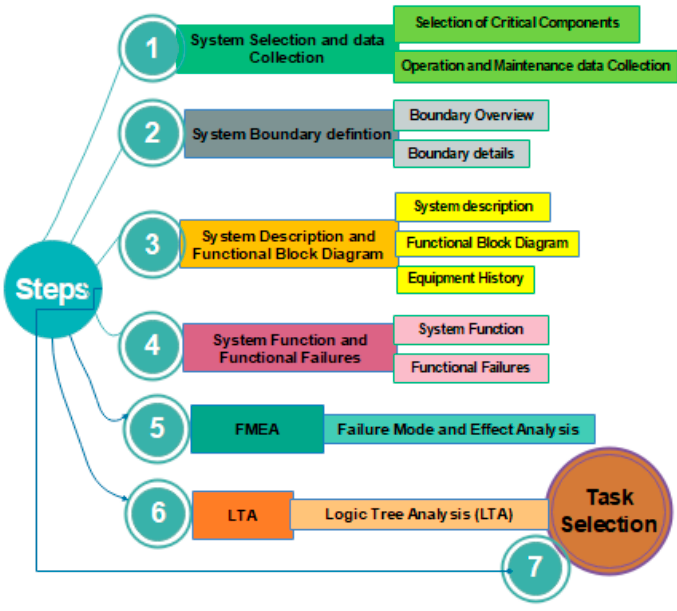
Figure 5. A flowchart for the RCM analysis [21].